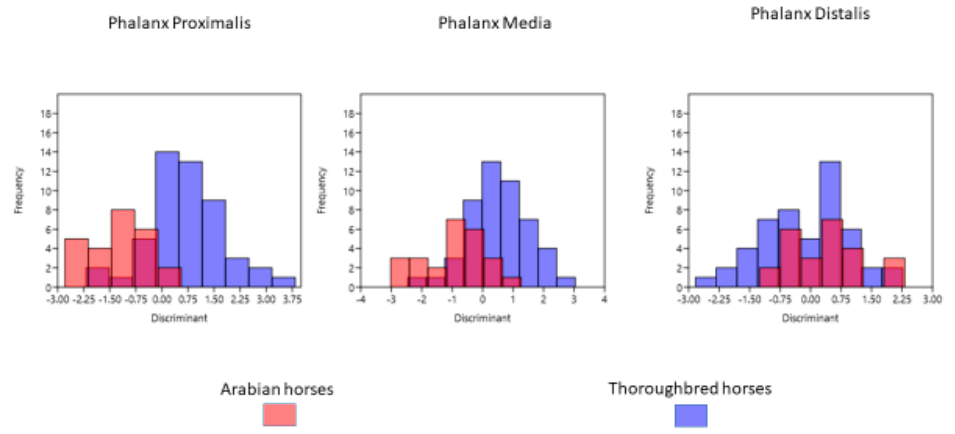
Figure 2. Distribution frequency of Arabian horses and Thoroughbred horses after discriminant analysis.